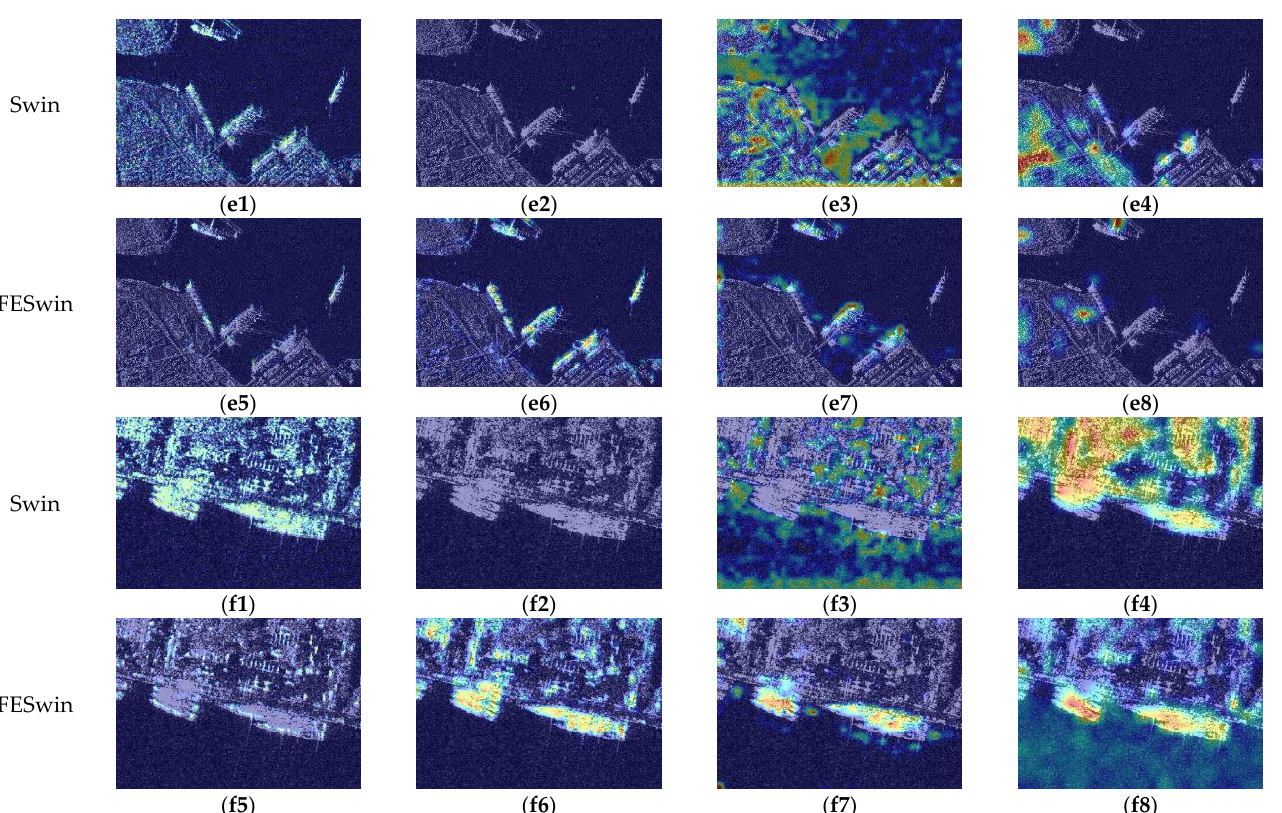
Figure 9. Results of FESwin effect comparison. ( a – c ): images of small, medium, and large ships in the far-sea region; ( d – f ): images of small, medium, and large ships in the near-shore region. ( 1 – 4 ): feature extraction results of four stages of Swin transformer; ( 5 – 8 ): feature extraction results of four stages of FESwin.